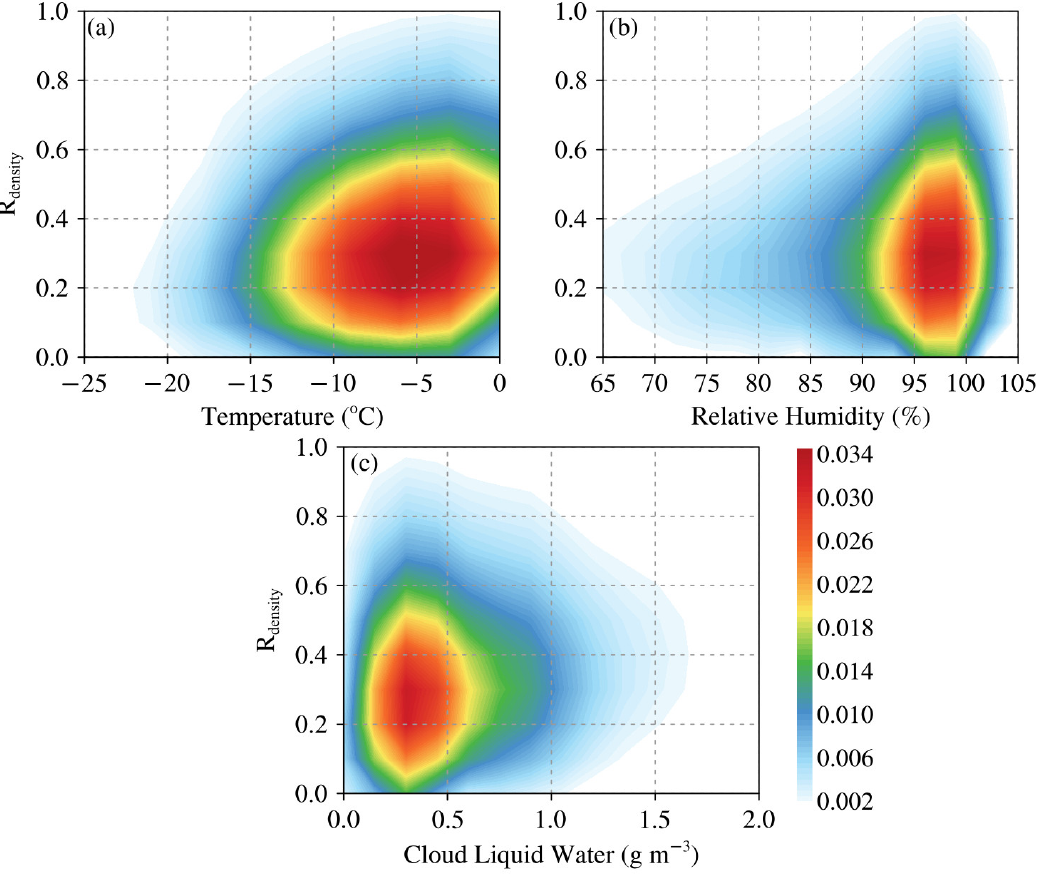
Remote Sens. 2022 , 14 , 5512 Figure 6. Dependence of R density on ( a ) temperature, ( b ) relative humidity and ( c ) cloud liquid water. Shading represents the normalized occurrence frequencies.